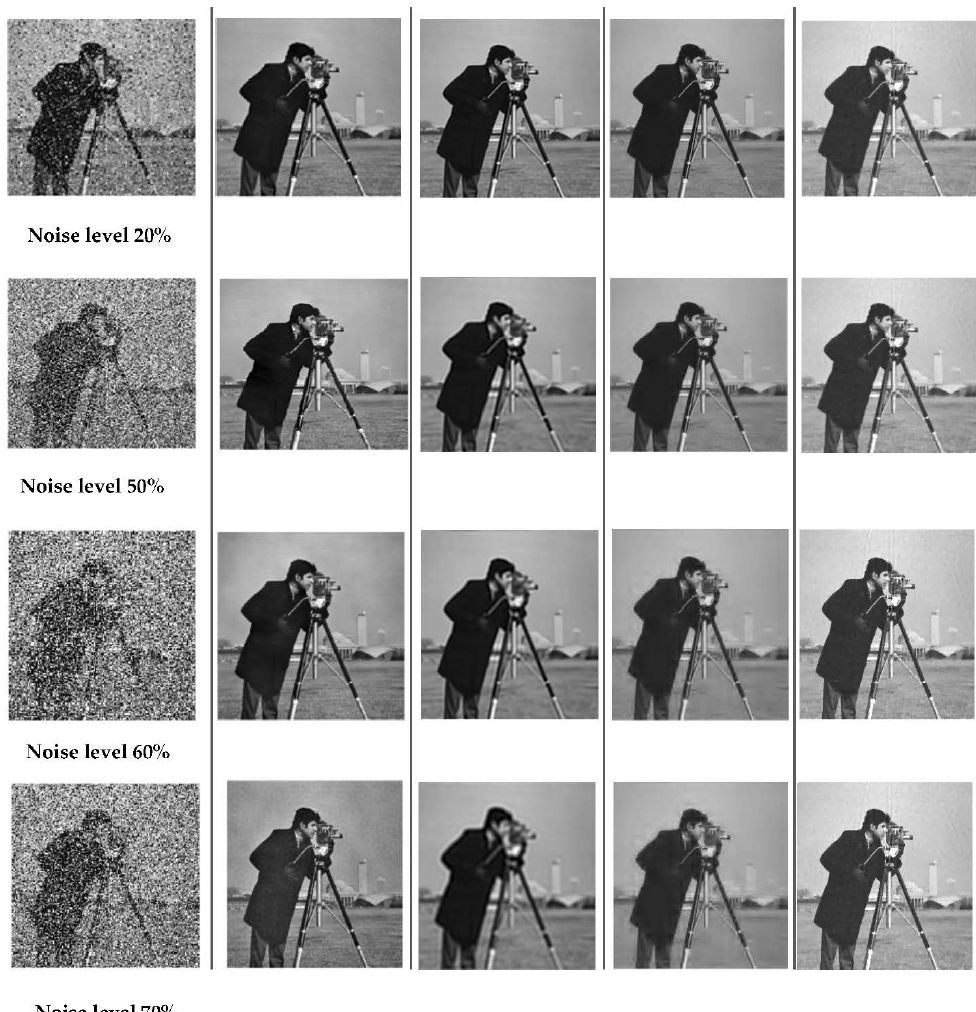
Figure 3. Visual comparison of the reconstruction quality for different noise levels in the case of salt and pepper (see column 1 located on the left side). The algorithms used are DCSR, GSR, wavelet denoising and NESTA: the denoised images are arranged in columns 2, 3, 4 and 5,